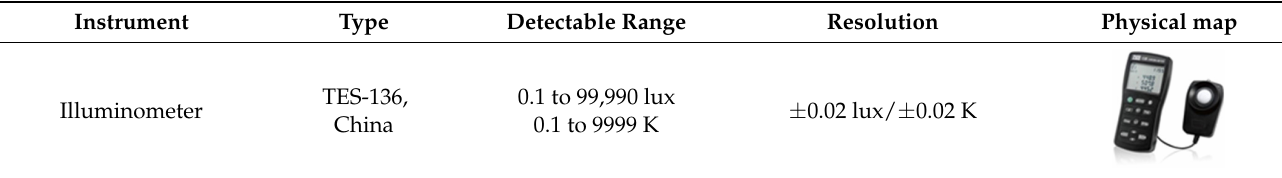
Table 2. Experimental